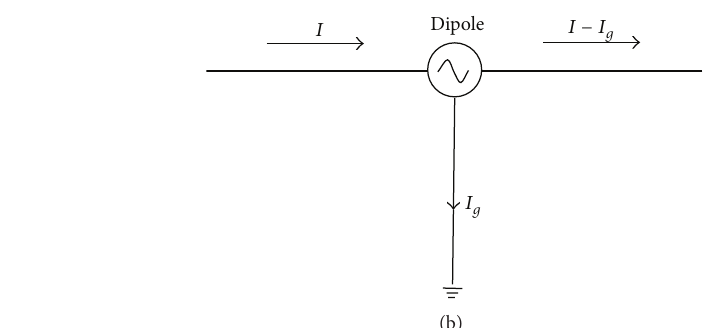
arm of the dipole, downward onto the inner conductor, and returns to the generator. The current, −𝐼 , flows upward along the inside surface of the feed-line shield until it reaches the junction of the right arm of the dipole. At this junction, the current −𝐼 divides into two separate paths to form 𝐼 − 𝐼 𝑔 and 𝐼 𝐼 𝑔 . Current 𝑔 flows back down the outside surface of the feed line. The magnitude of 𝐼 𝑔 depends on the impedance to ground determined by the outside surface of the coaxial